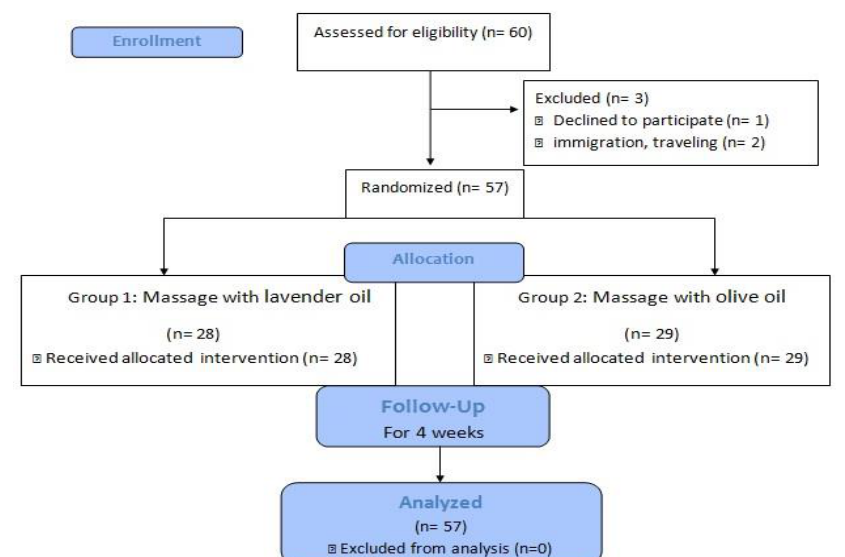
Figure. A flow diagram of the protocol